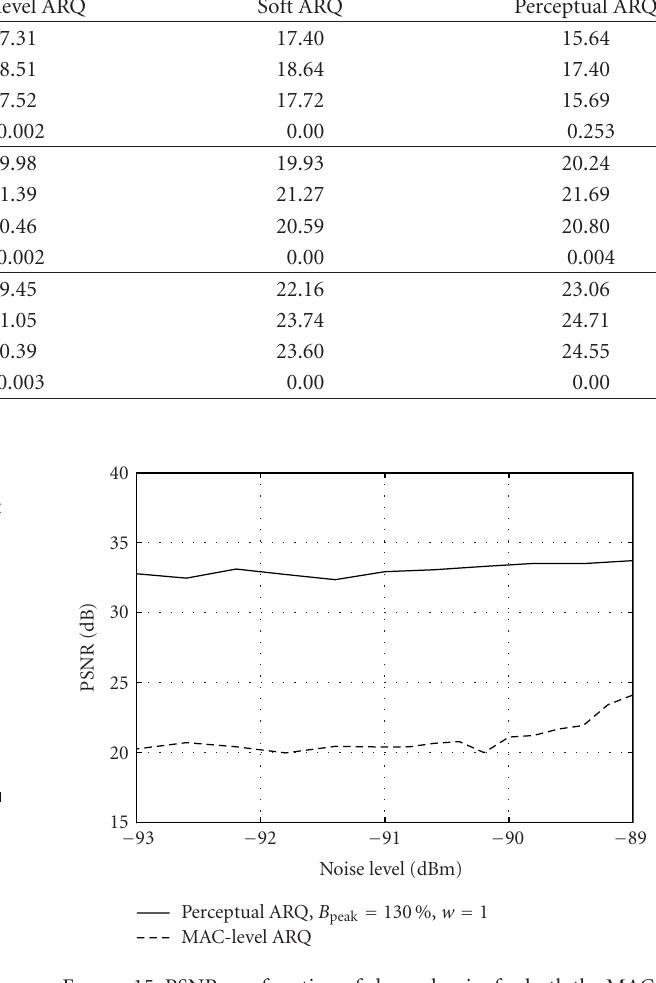
Figure 14: PSNR as a function of the Video #3 bandwidth (varied from 4 to 6Mbps) for both the MAC-level ARQ and the proposed ARQ scheme; tempete sequence.